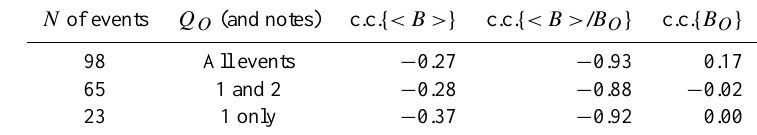
Table 2. Linear correlation coefficients for < | B | > , < | B | > / B O and B O vs. | CA | .